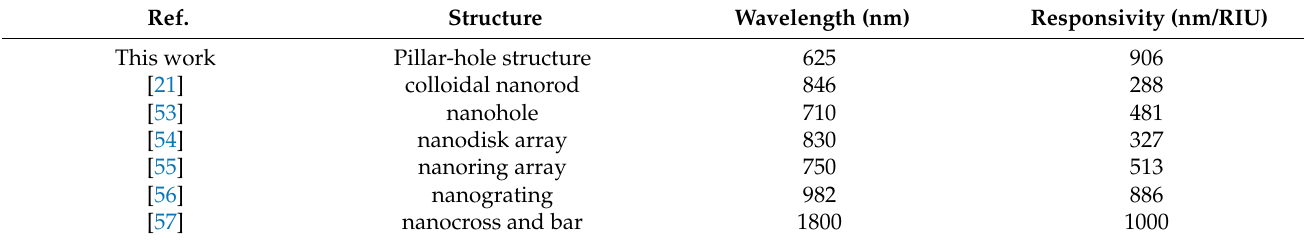
Table 1. Comparison of refractive index response properties of plasmonic nanostructures in previous works and this work.